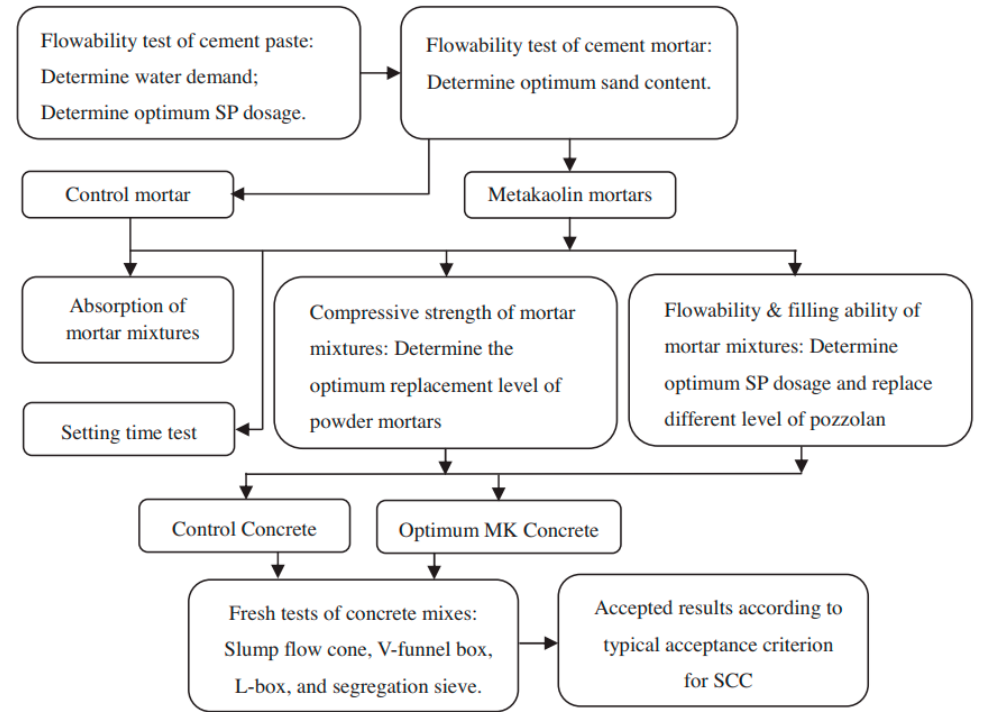
Figure 2. Mixture design procedure of method proposed by Khaleel – empirical design method [18]. Reproduced with permission from C. Shi, Z. Wu, K. Lv and L. Wu, A review on mixture design methods for self-compacting concrete; published by Elsevier, Construction and Building Materials, 2015.